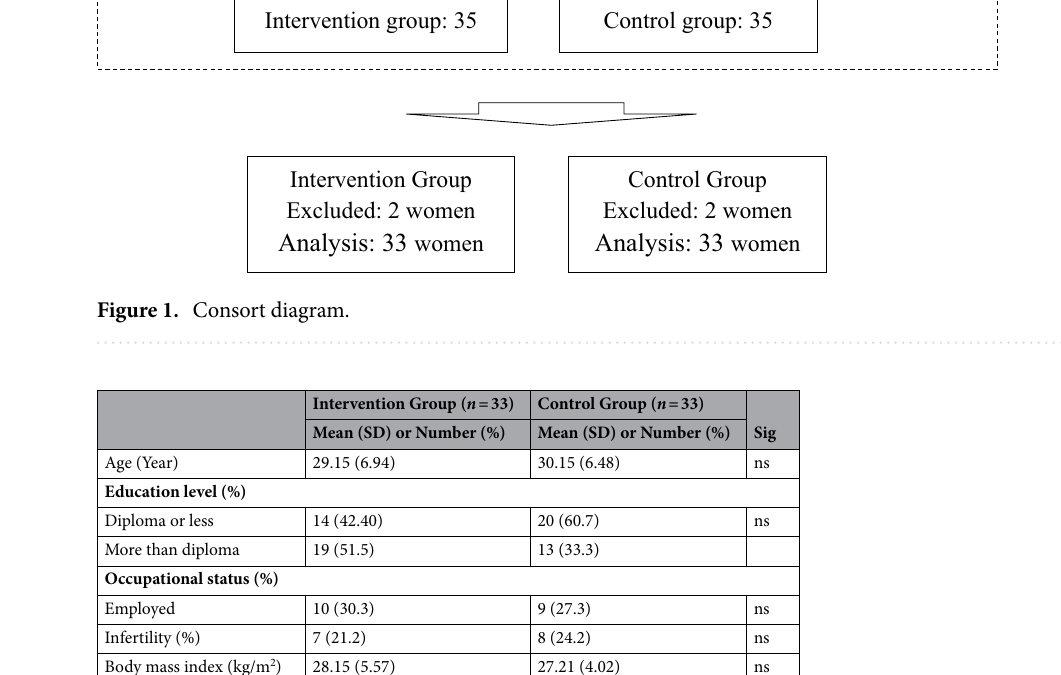
Table 1. Comparison of baseline characteristics in study groups. SD standard deviation; sig significance; ns not significant.